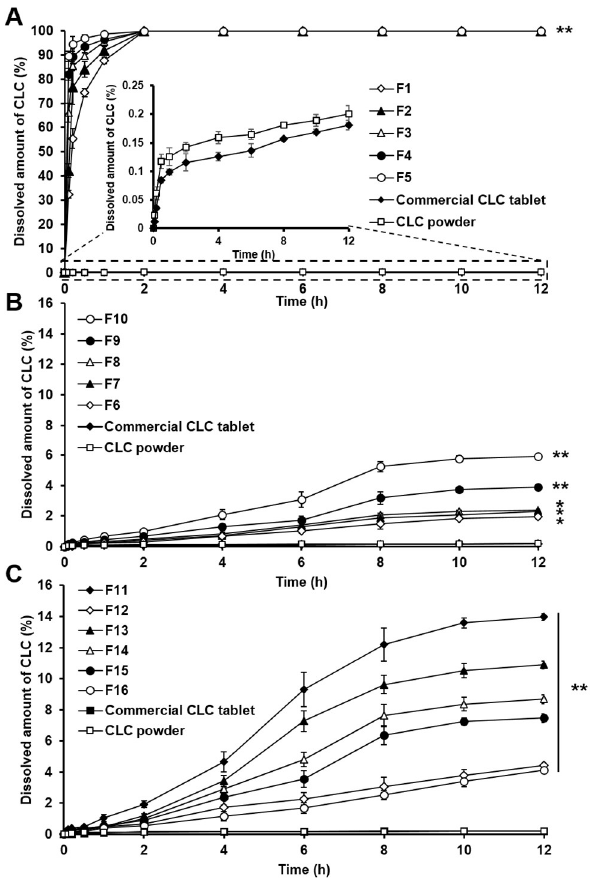
Figure 5. Dissolution profiles of CLC in water evaluated with ( A ) F1–F5, ( B ) F6–F10, and ( C ) F11–F16 for 12 h in comparison to those of commercial CLC 200 mg tablet and CLC powder. For clarity, the dissolution profiles of the commercial CLC tablet and CLC powder are expanded in the inserted graph in panel A. The dissolved amounts of CLC are presented as mean ± SD ( n = 3) as a function of time up to 12 h. Single and double asterisks indicate the statistical differences in amounts of CLC dissolved at 12 h assessed with different PC-based dispersion formulations at P < 0.001 and P < 0.0001, respectively, compared to that observed with the commercial CLC tablet. In panel A, all dissolved amounts of CLC were statistically greater than those of the commercial CLC tablet and CLC powder at P < 0.0001 marked with double asterisks.